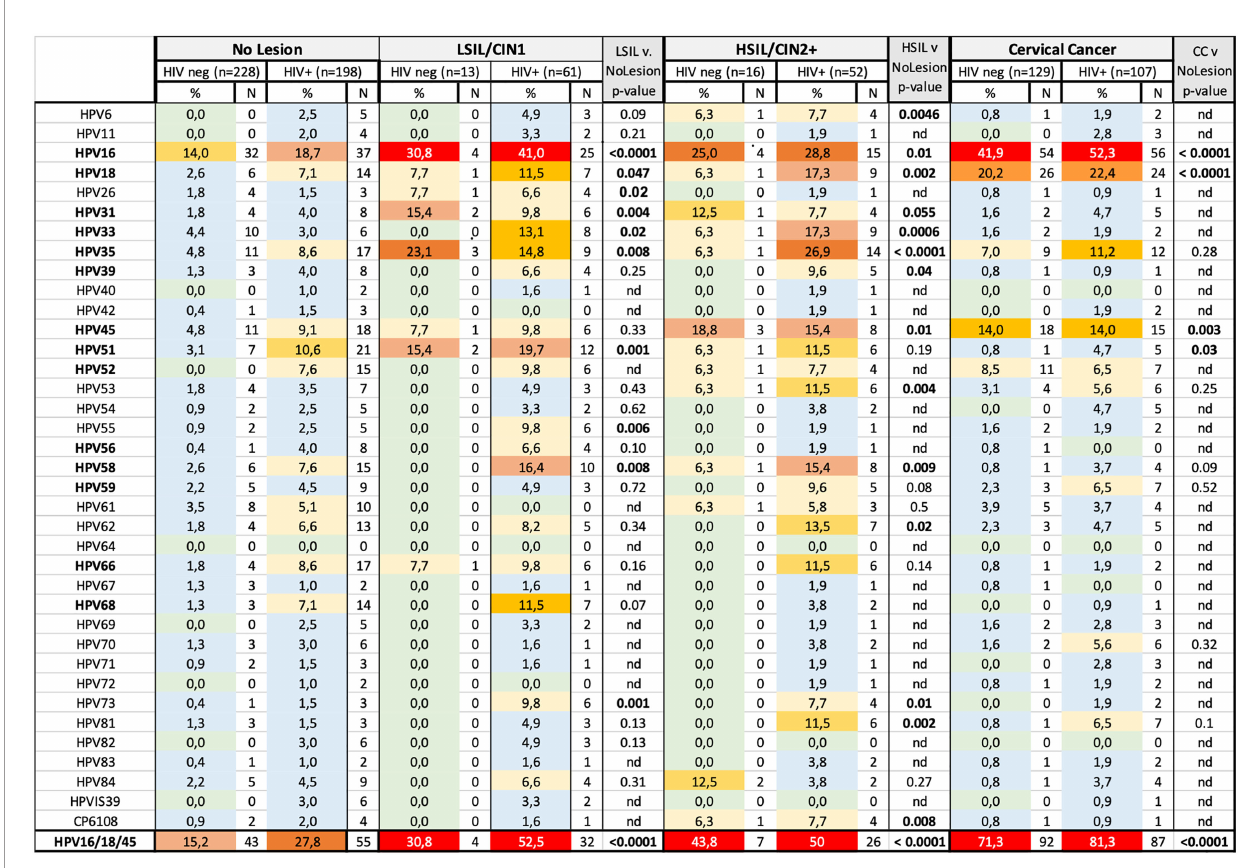
FIGURE 3 | Frequency of occurrence of HPV types in HIV+ and HIV − women strati fi ed by cytohistological diagnosis. HR-HPV types are indicated in bold. Frequencies are color coded in different shades as follows: 0% (light green), 0.1 to 5.0% (light blue), 5.1 to 10.0% (light yellow), 10.1 to 15.0% (light orange), 15.1 to 20.0% (faint red), 20.1 to 25.0% (orange), 25.1 to 30.0% (red-orange), >30.0 (strong red). The two-sided Fisher ’ s exact test was for signi fi cance testing and was calculated to compare all women with cervical cancer, HSIL, LSIL to women without lesion, regardless of HIV status. nd, not